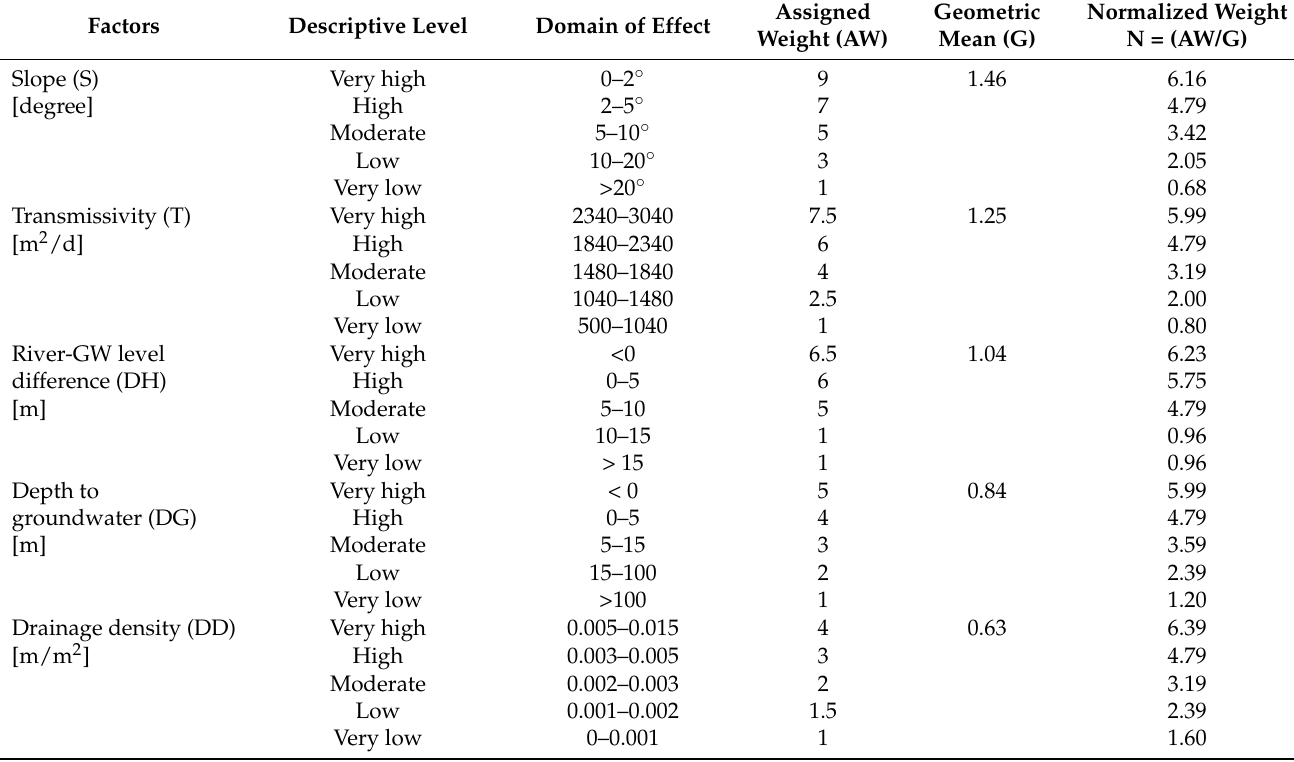
Table 2. Assigned and normalized weights of feature classes for the selected parameters to calculate interflow potential.